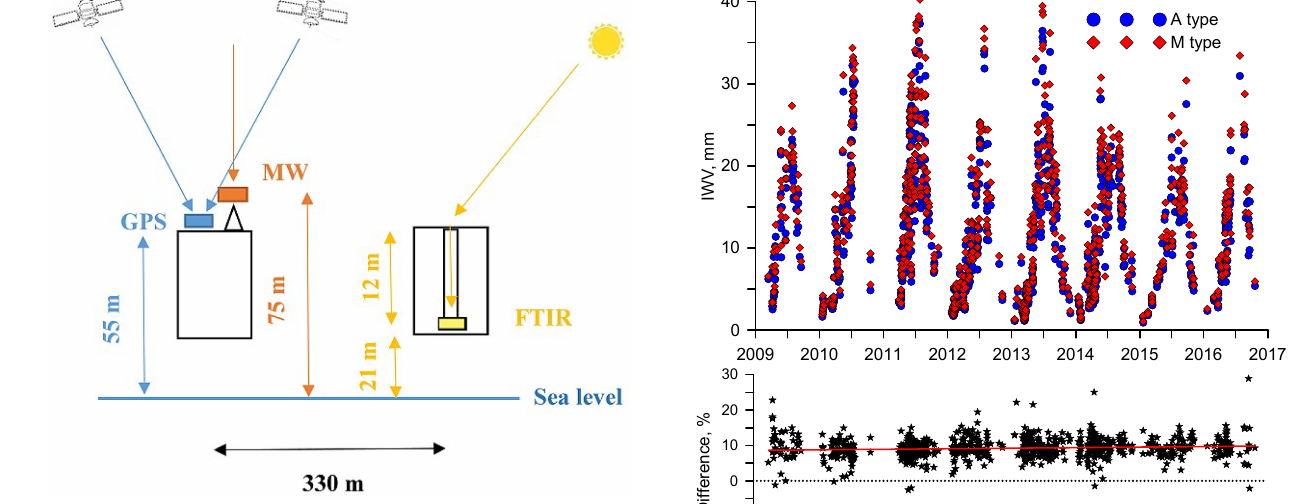
Figure 3. Schematic location of FTIR, MW, and GPS instrumenta- tion at the St. Petersburg site.